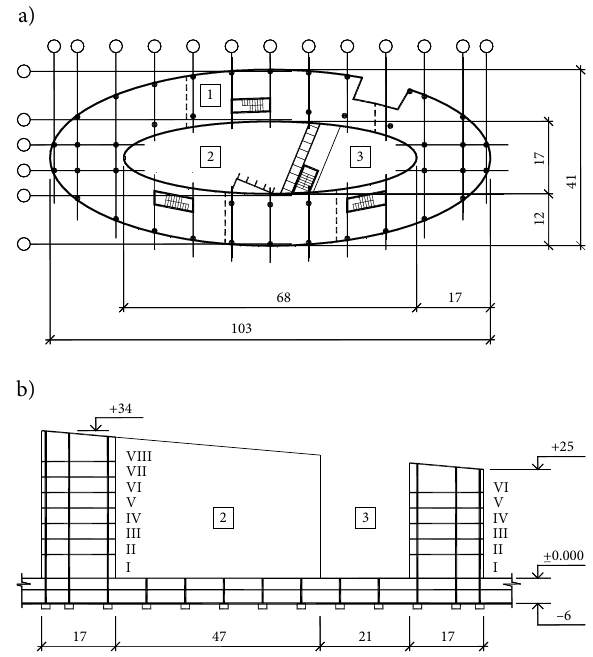
Fig. 2. A typical plan (a) and longitudinal section (b) of the considered building: 1 – a slab; 2 – the inside